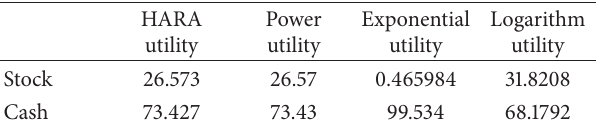
Table 3: The optimal policy with liability and constant interest